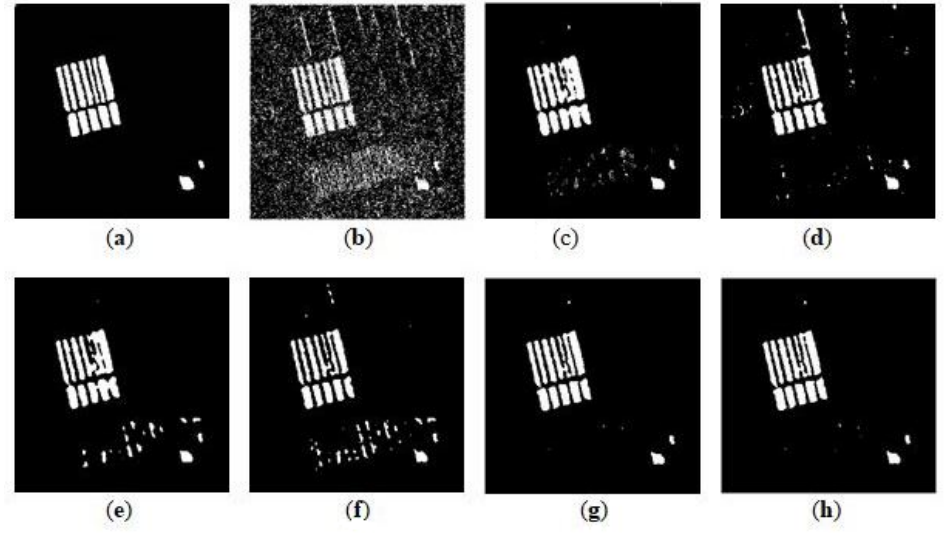
Figure 4. Visual comparison of CD results using various methods for Farmland C: ( a ) reference,